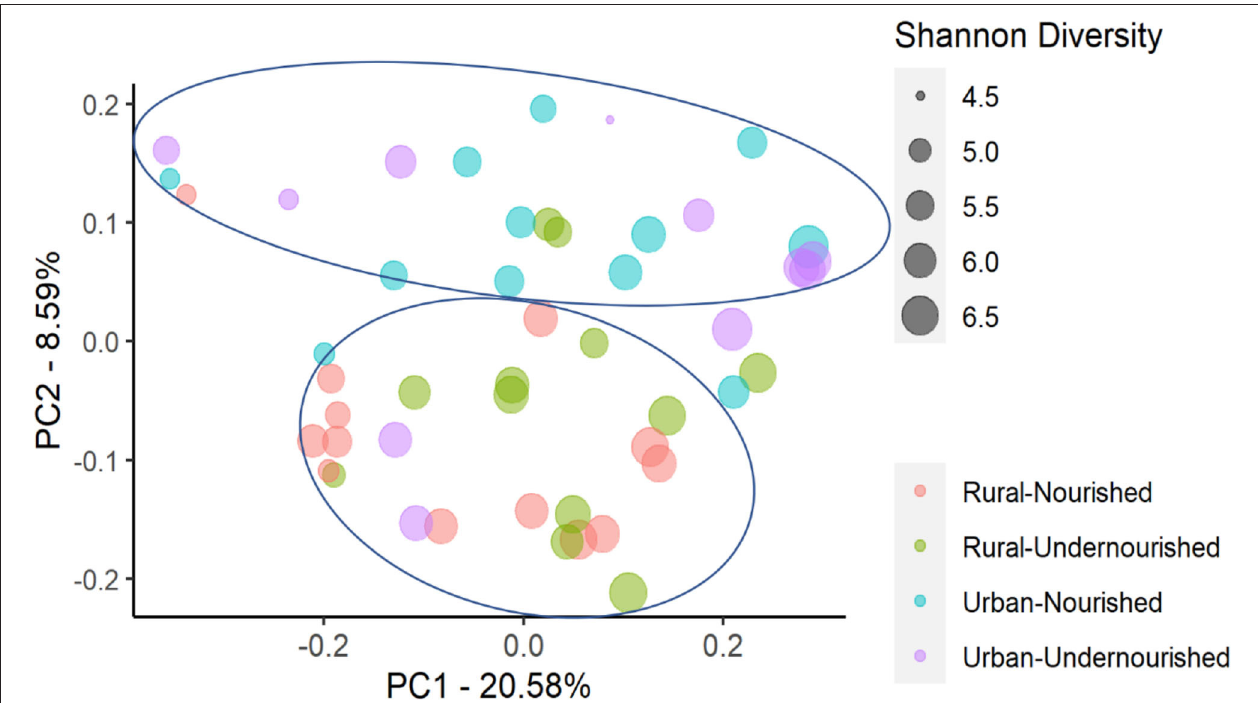
FIGURE 3 | Principal Coordinates Analysis (PCoA) of the similarity across the study groups based on the nutritional status (nourished vs. undernourished) and location (rural vs. urban slum) based on the Unweighted UniFrac distances. Each point corresponds to a sample colored according to the nutritional status and corresponding location and the size of the point corresponds to the Shannon diversity index. Principal Coordinates (PC) axis expresses the percent variance across the